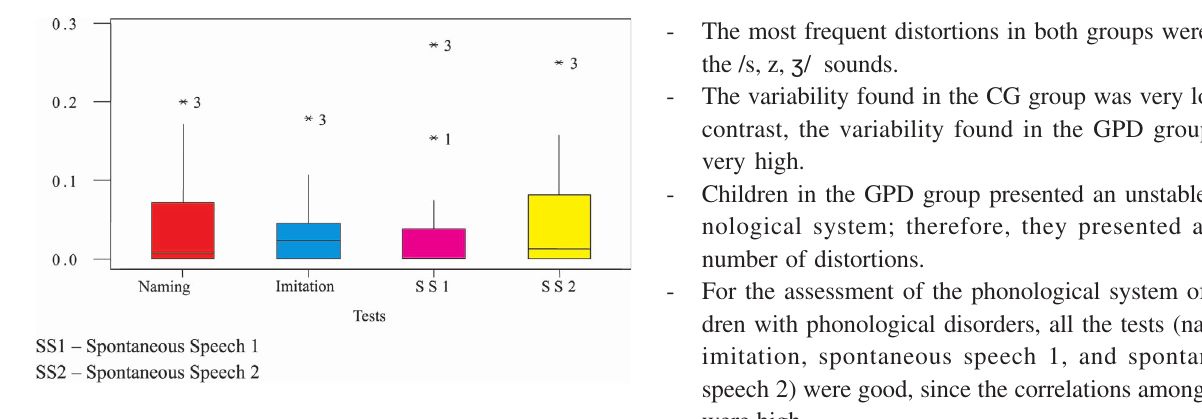
Figure 8 - Box plot of proportions of distortion occurrences in the Group with Phonological